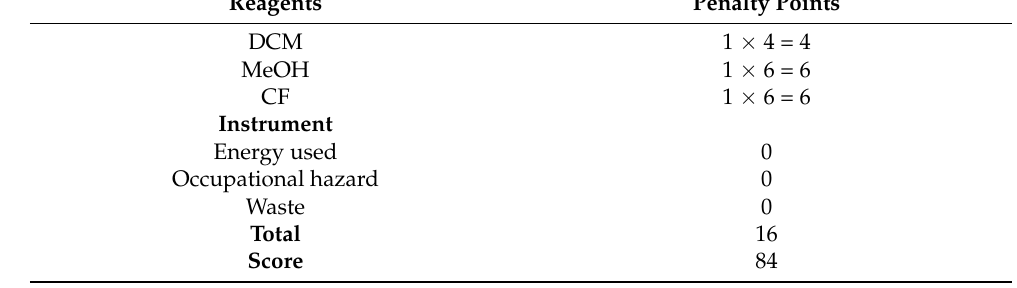
Table 3. Penalty points calculated by Analytical Eco-Scale score.